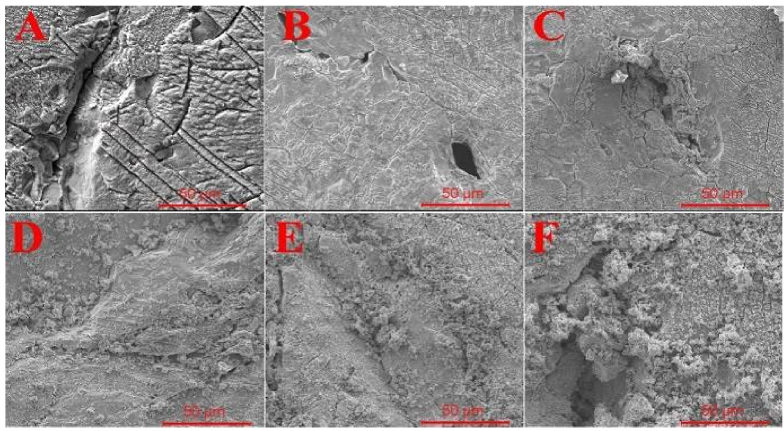
Figure 7. SEM images of the chalcopyrite surface treated at − 0.54 V at different leaching times: ( A ) day 0; ( B ) day 2; ( C ) day 4; ( D ) day 6; ( E ) day 8; and ( F ) day 10.